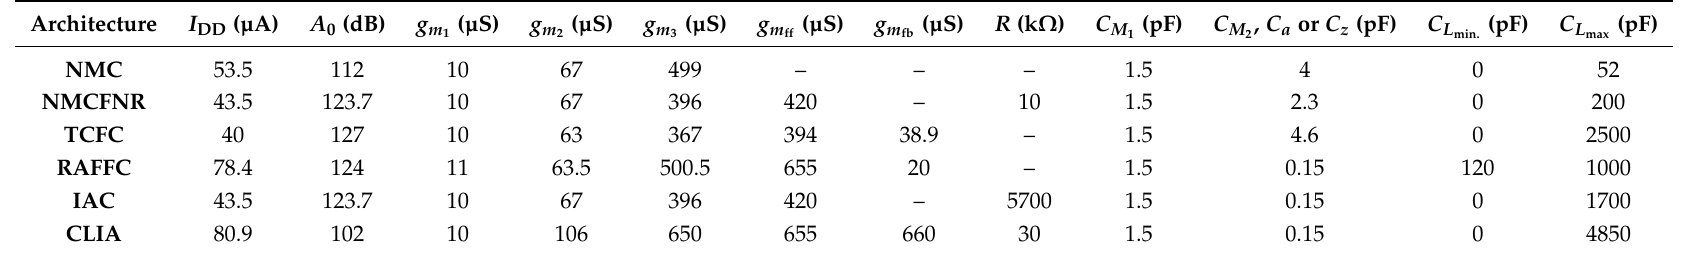
Table 10. Simulation results for the selected OTA